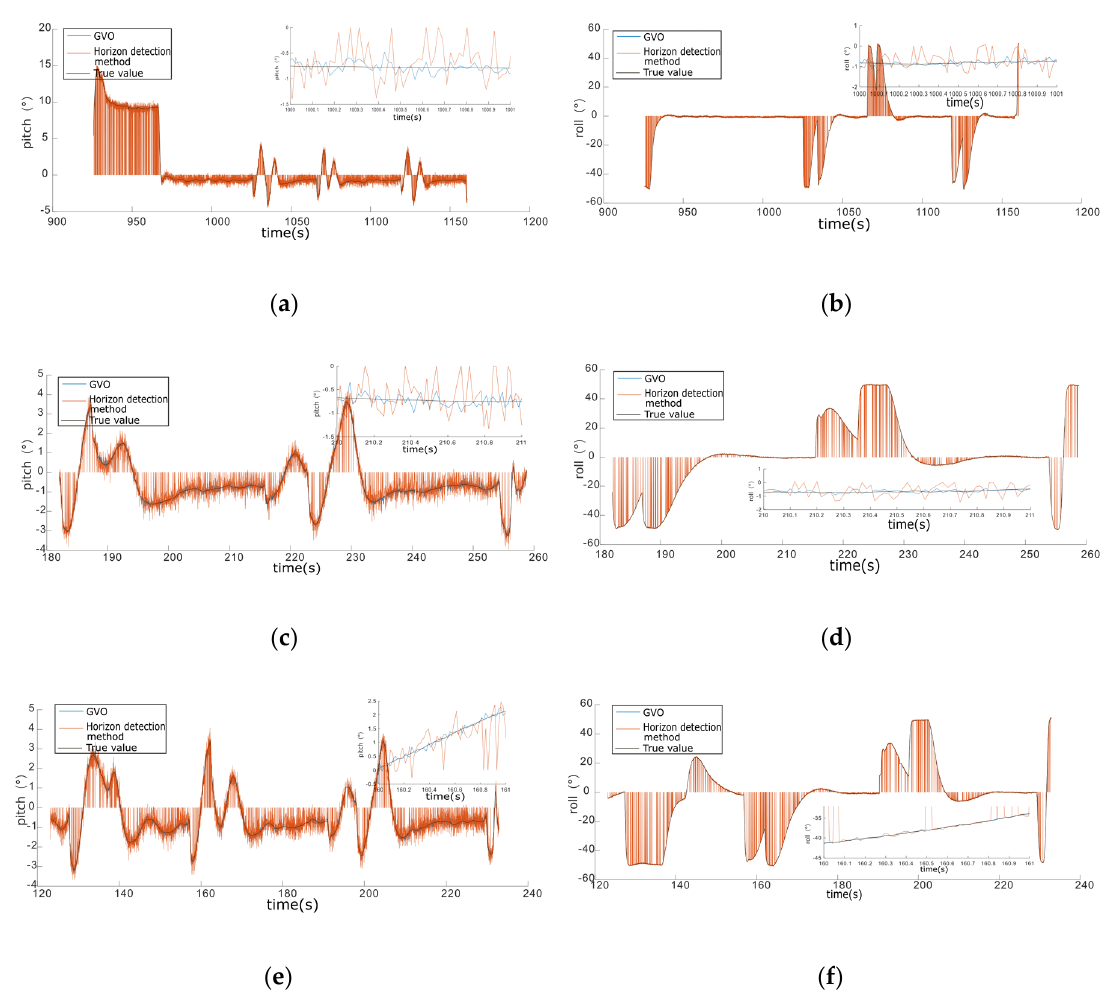
Figure 9. The simulation results of GVO and horizon detection method in the mountainous area. ( a ) Pitch angle of 100 m height. ( b ) The roll angle of 100 m height. ( c ) Pitch angle of 200 m height. ( d ) The roll angle of 200 m height. ( e ) Pitch angle of 300 m height. ( f ) The roll angle of 300 m height.